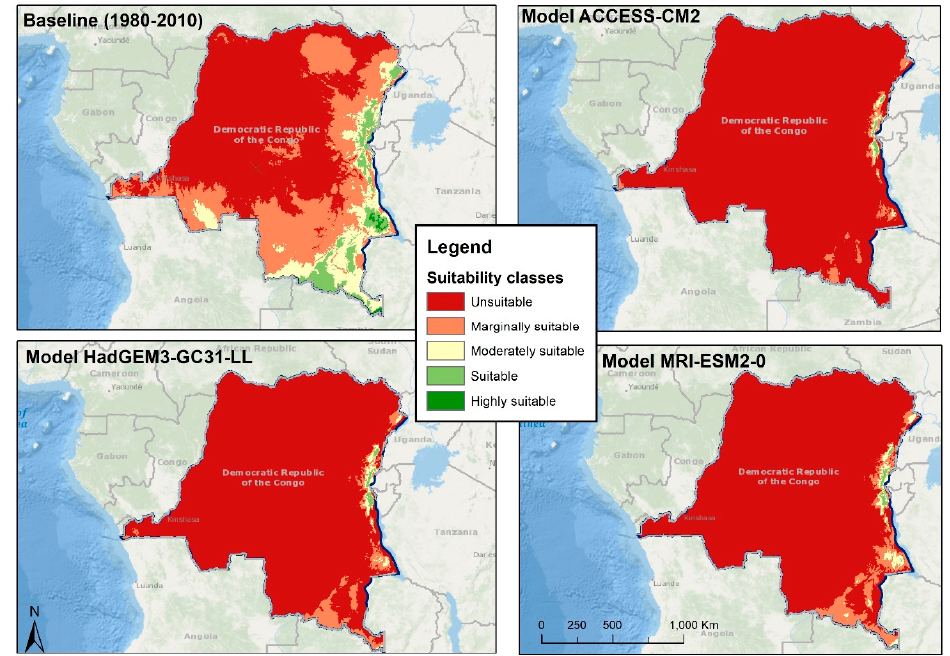
Figure 4. Common beans climate suitability under climate change conditions (ssp585) for 2061–2080 in DRC.